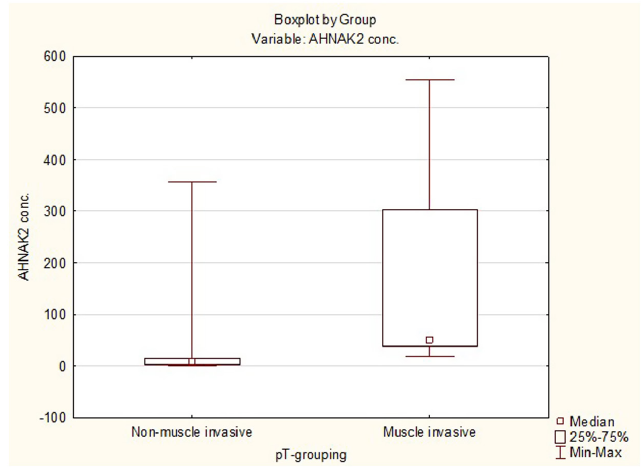
Figure 3. Boxplot comparing AHNAK2 urinary levels in patients with non-muscle invasive bladder cancer (pTa, pTis, pT1) and muscle-invasive bladder cancer (pT ≥